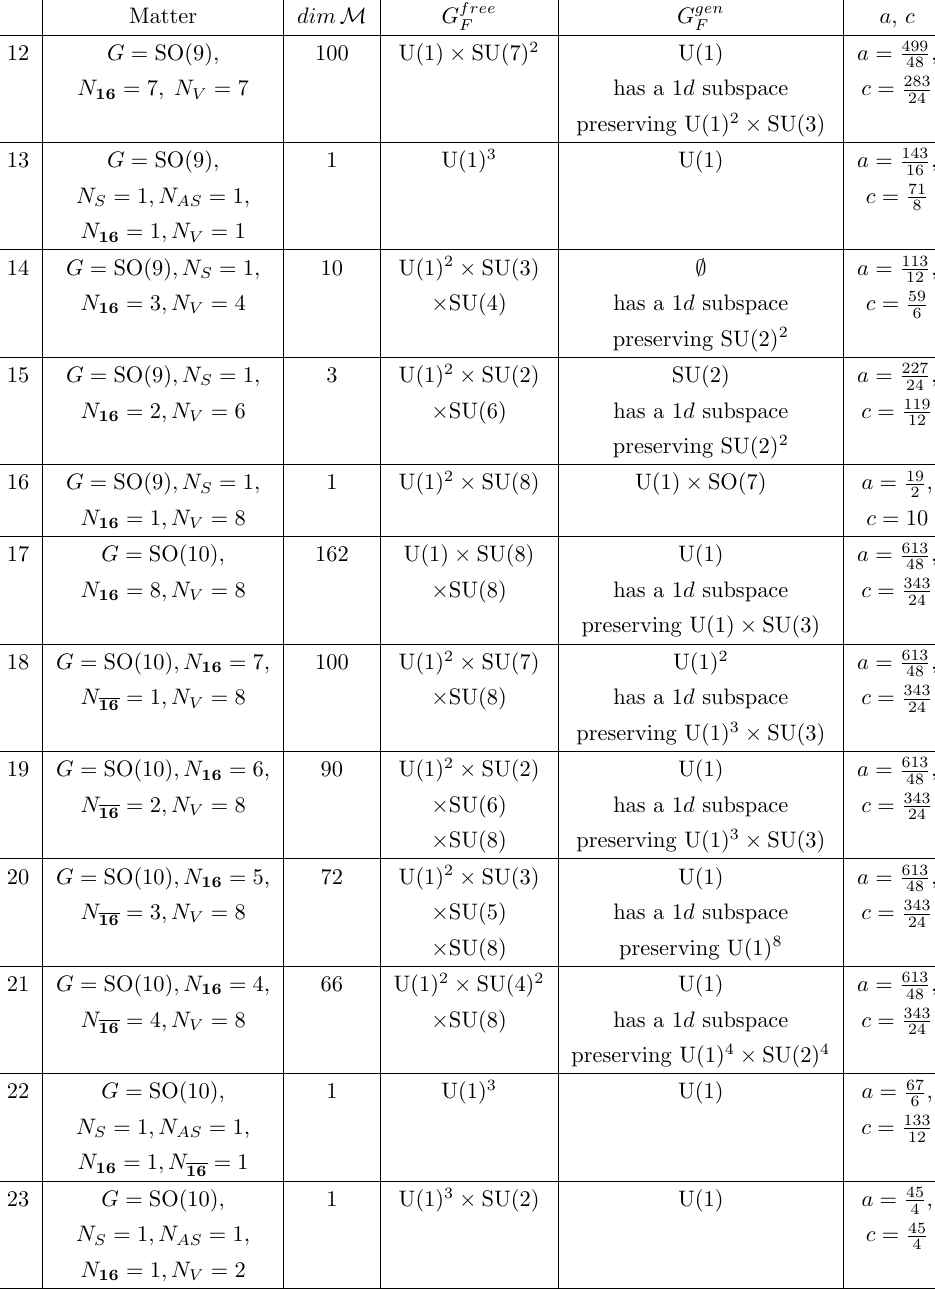
Table 21 . Cases involving an SO(9) or SO(10) gauge group with ‘exotic’ matter.